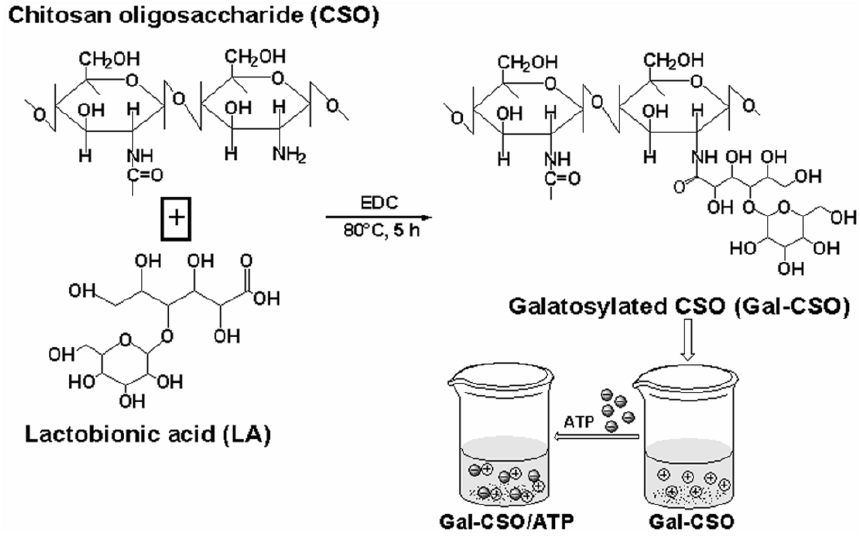
Figure 1. Synthetic route of galactosylated chitosan oligosaccharide (Gal-CSO) and schematic representation depicting the formation of Gal-CSO/adenosine triphosphate